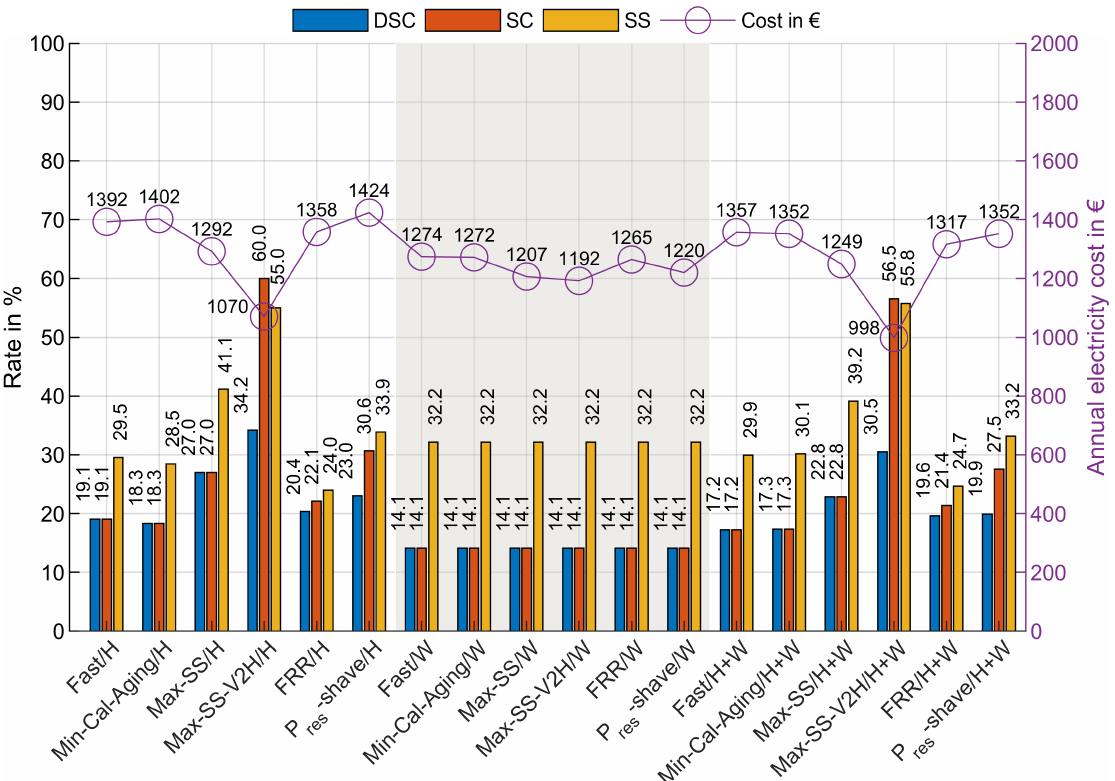
Figure 10. DSC, SC, and SS rates, and electricity cost for mobility profile 2nd Car without SoC V 2 XLimit .